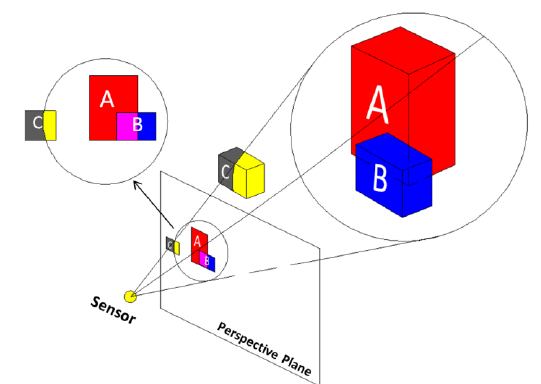
Figure 7. Classifying the projected polygons on the perspective plane respect to their position in the perspective circle